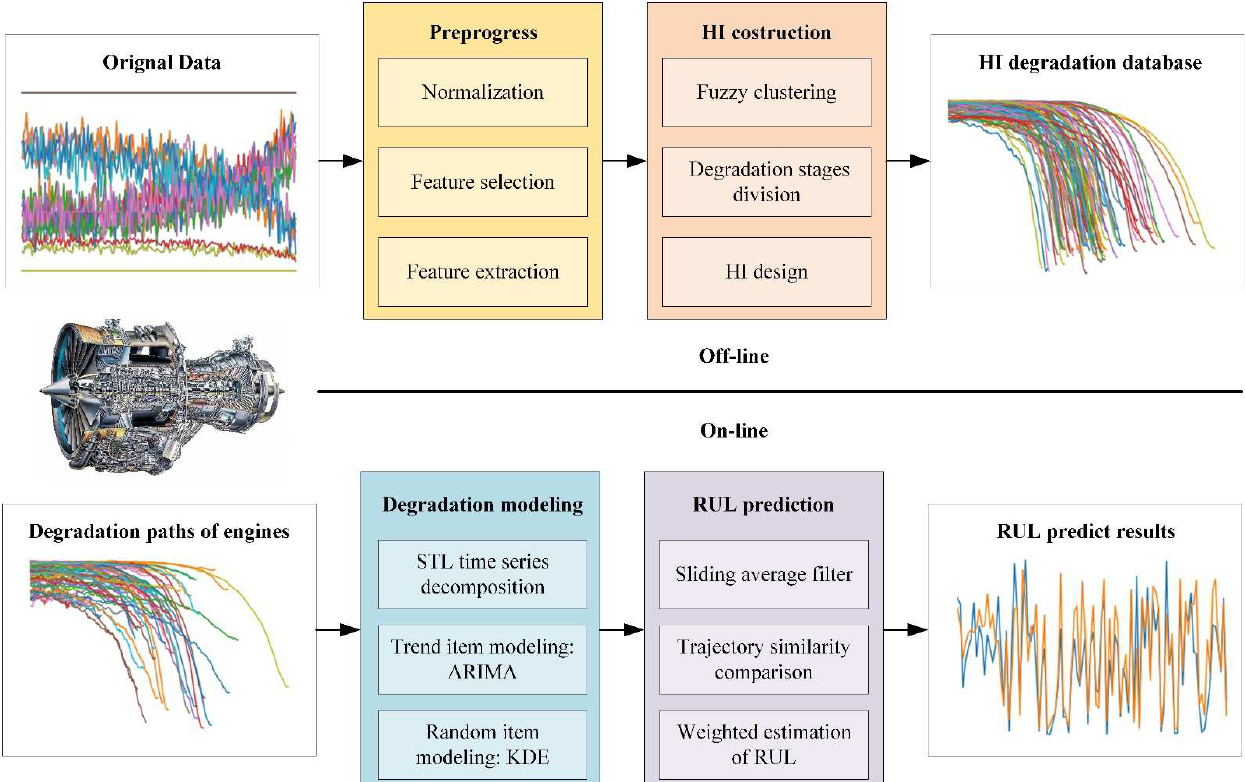
Figure 2. The overall framework for RUL predictions based on STL modeling and similarity meas- Figure 2. urements.